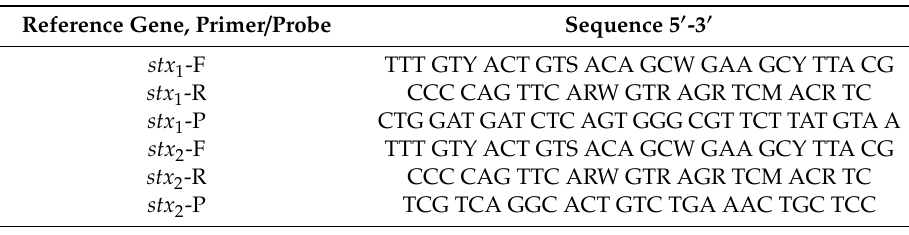
Table 1. Primer and probe sequences used in this study